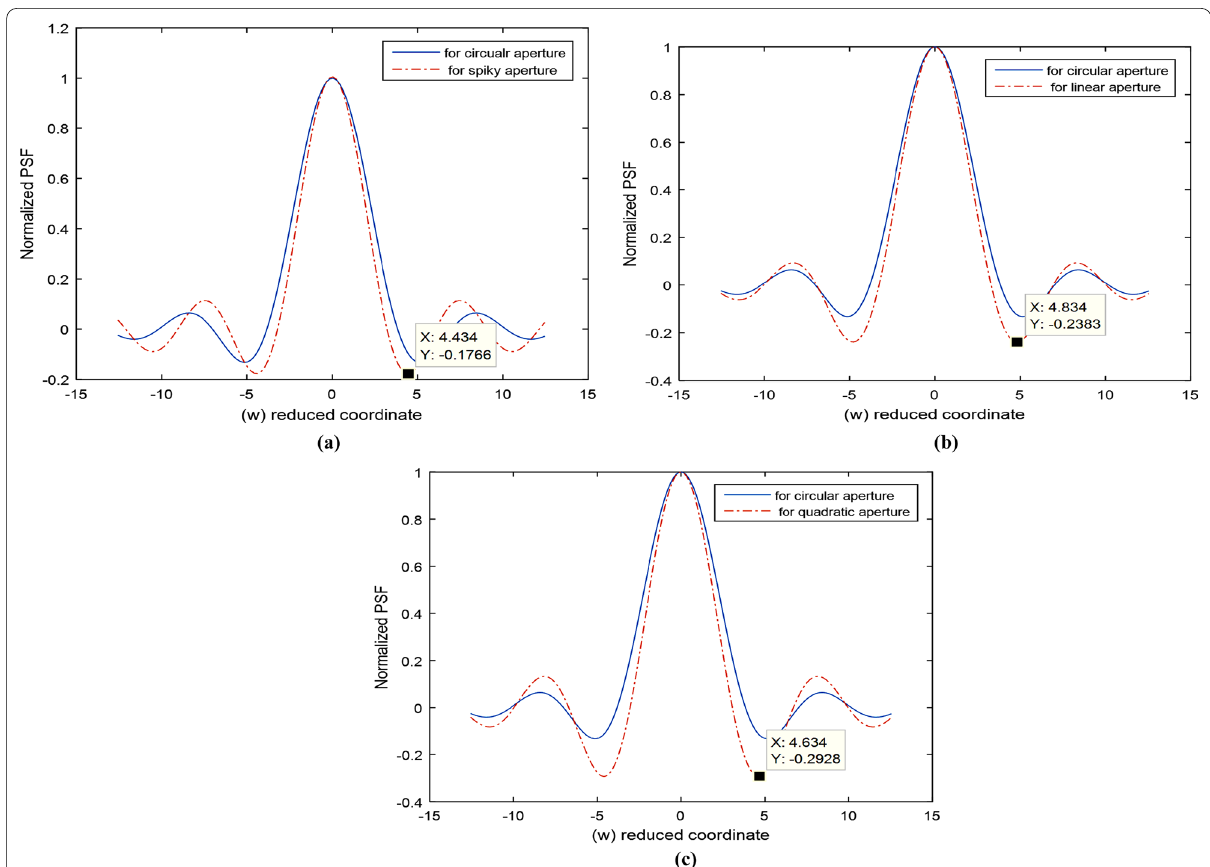
Fig. 10 a Normalized PSF computed from Eq. (8) for the spiky pattern where β 0.5 computed from Eq. (12) for the circular aperture. The same = reduced coordinate range is taken constant from 4*pi to 4*pi in both plots. b : The Normalized PSF for the linear aperture compared with that − corresponding to the circular aperture. The same reduced coordinate range is taken constant from 4*pi to 4*pi in both plots. c : The Normalized − PSF for the quadratic aperture is compared with that corresponding to the circular aperture. The same reduced coordinate range is taken constant from 4*pi to 4*pi in both −